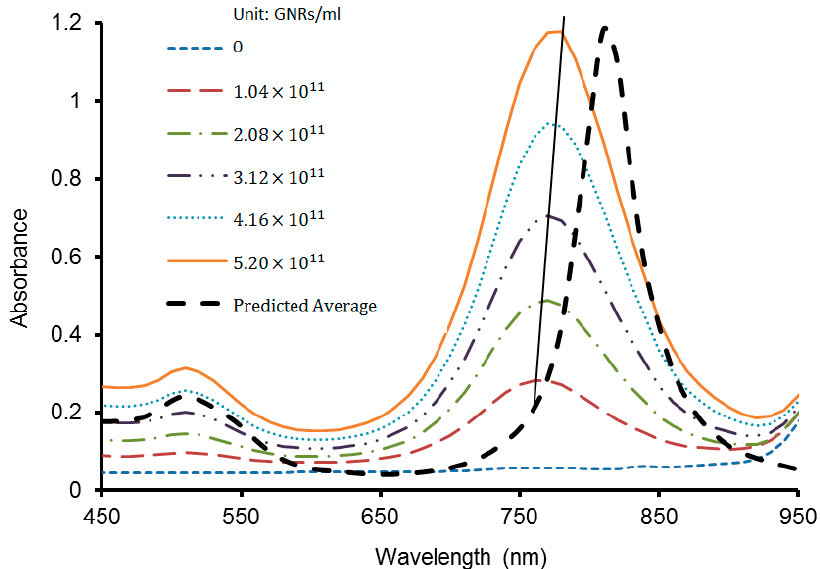
Figure 6. Measured absorbance of GNR solutions with various concentrations (see Table 1).